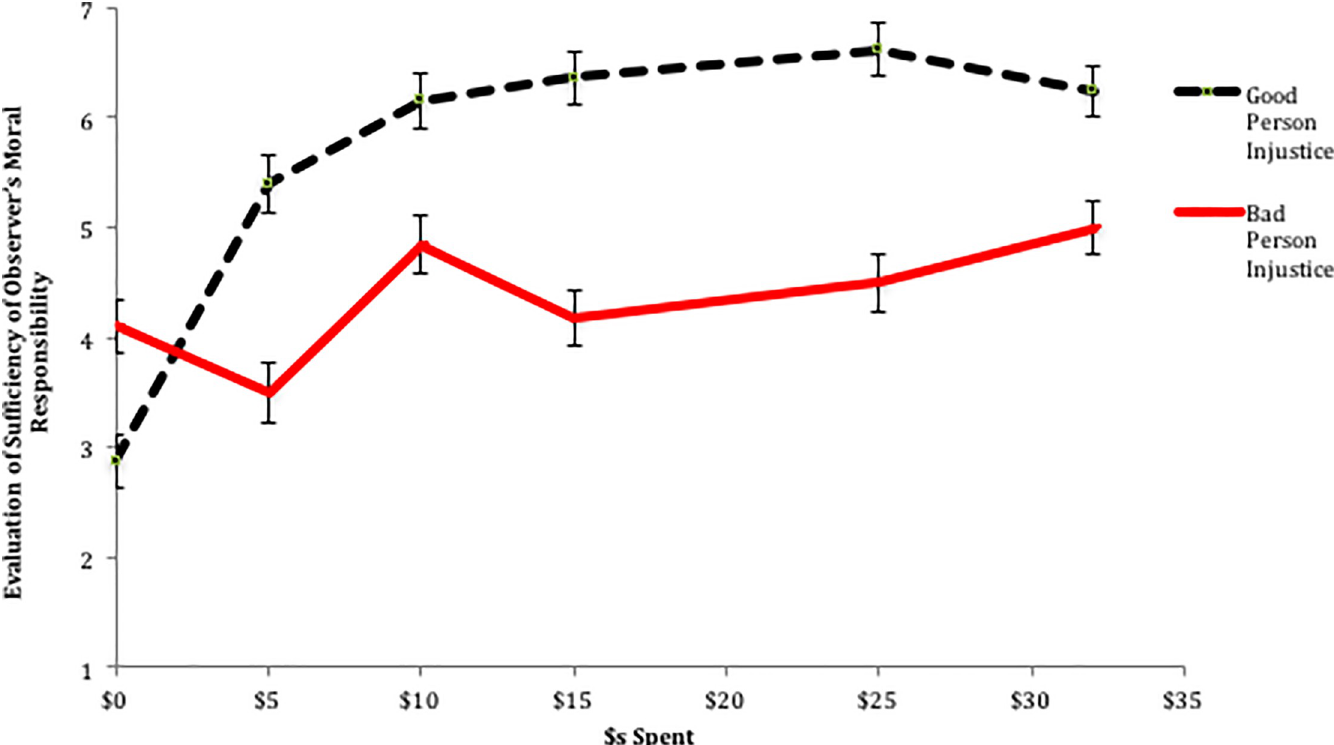
Fig 6. Study 3 evaluation of sufficiency of observer’s moral responsibility. Error bars represent standard errors.